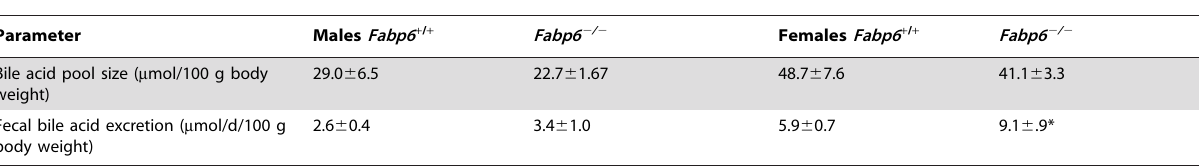
Table 2. Bile acid pool size and excretion rate.